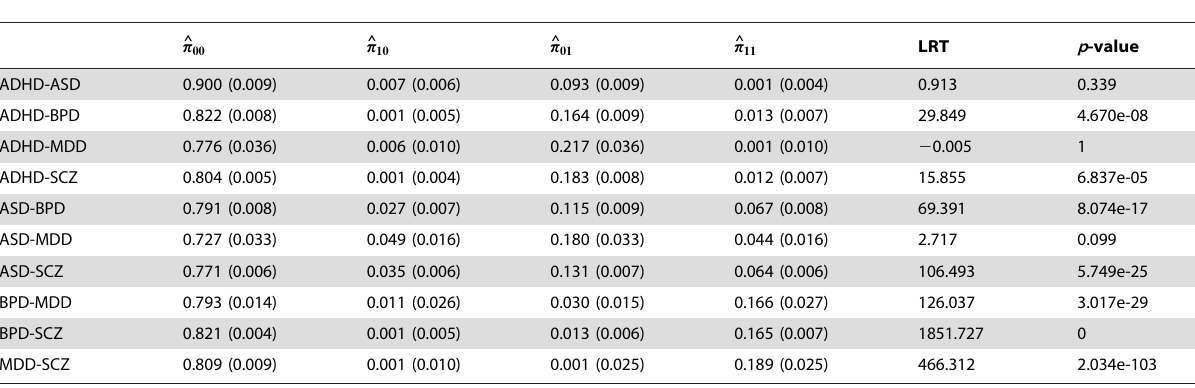
Table 2. Pleiotropy estimated among five psychiatric